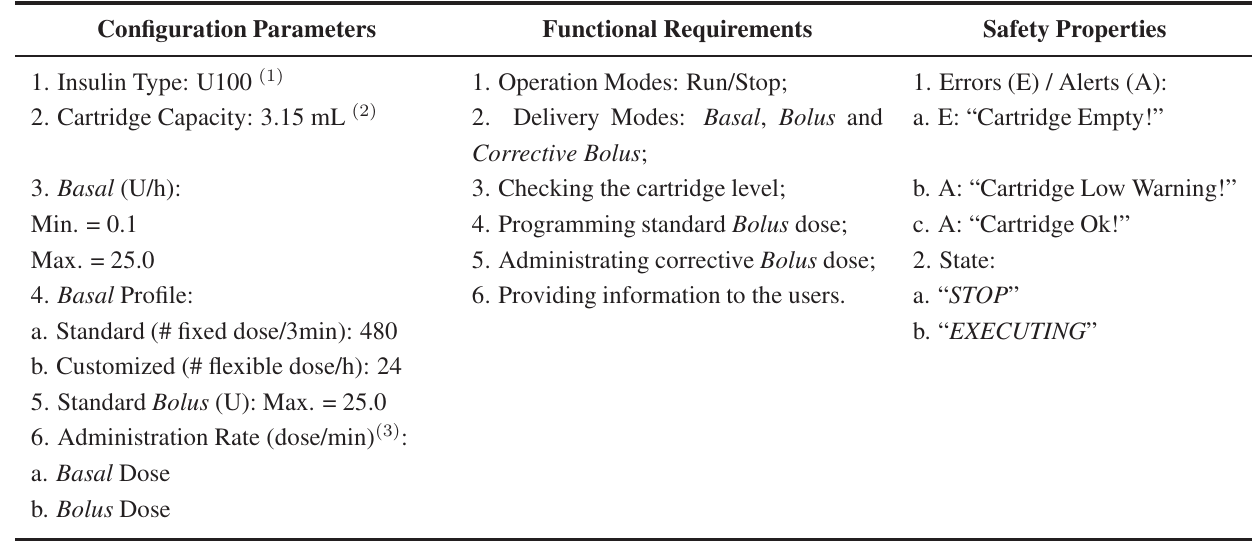
Table 3. Technical Requirements Considered in the Modeling Process of the Insulin Pump.